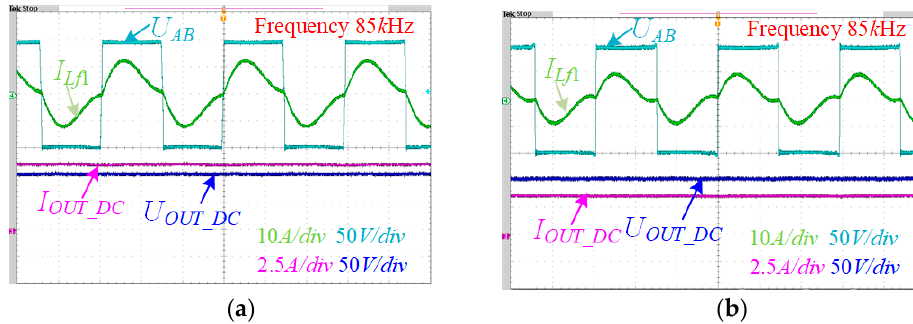
Figure 10. Waveform of the system: ( a ) alignment condition; ( b )100 mm offset condition.